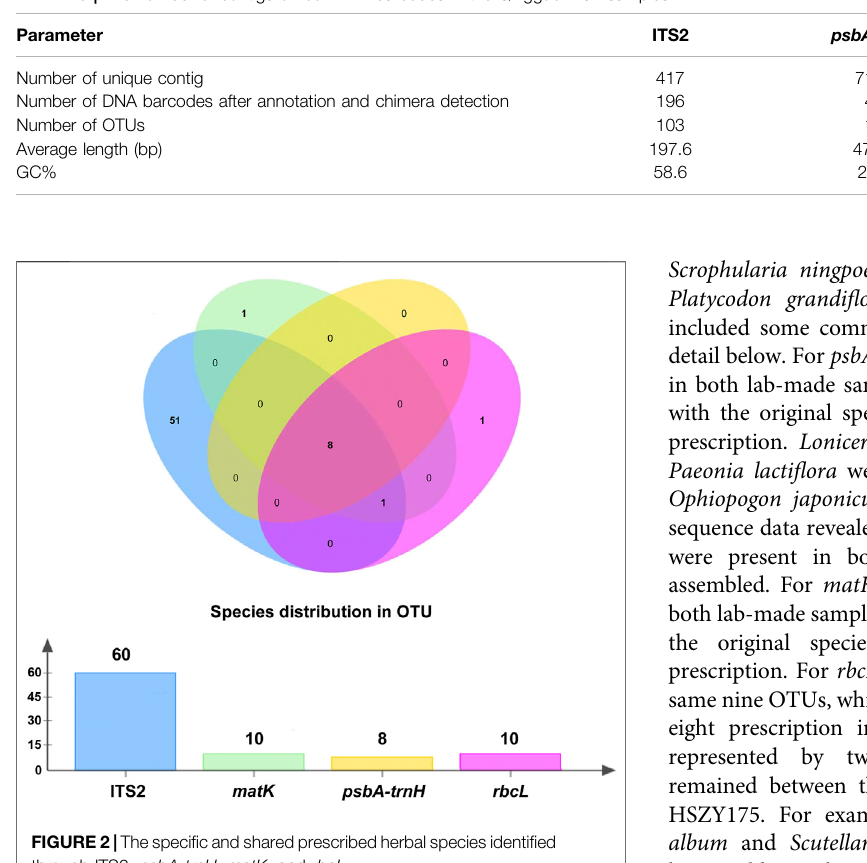
FIGURE2| Thespeci fi cand sharedprescribedherbal speciesidenti fi ed through ITS2, psbA-trnH , matK, and rbcL.